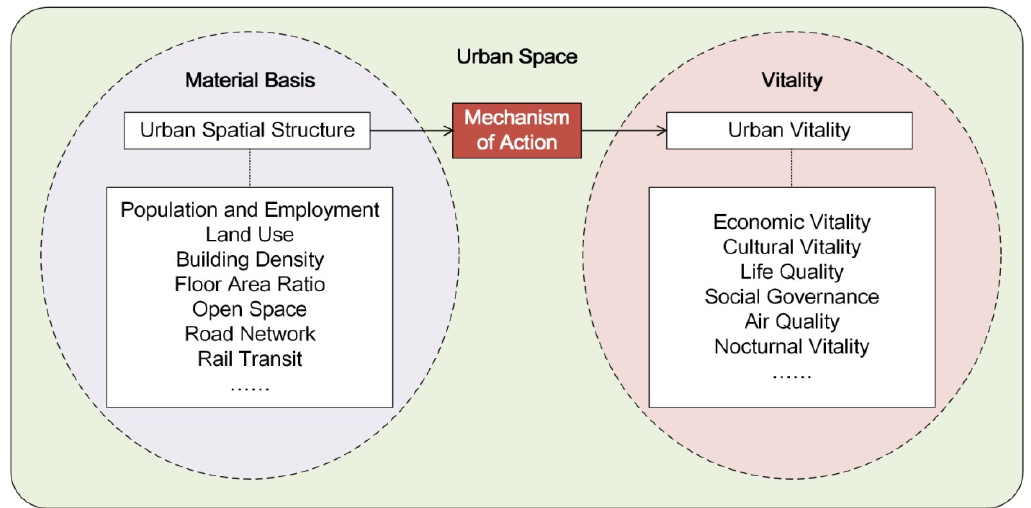
Figure 1. A theoretical model of the influence mechanism of urban spatial structure on urban vi- tality.